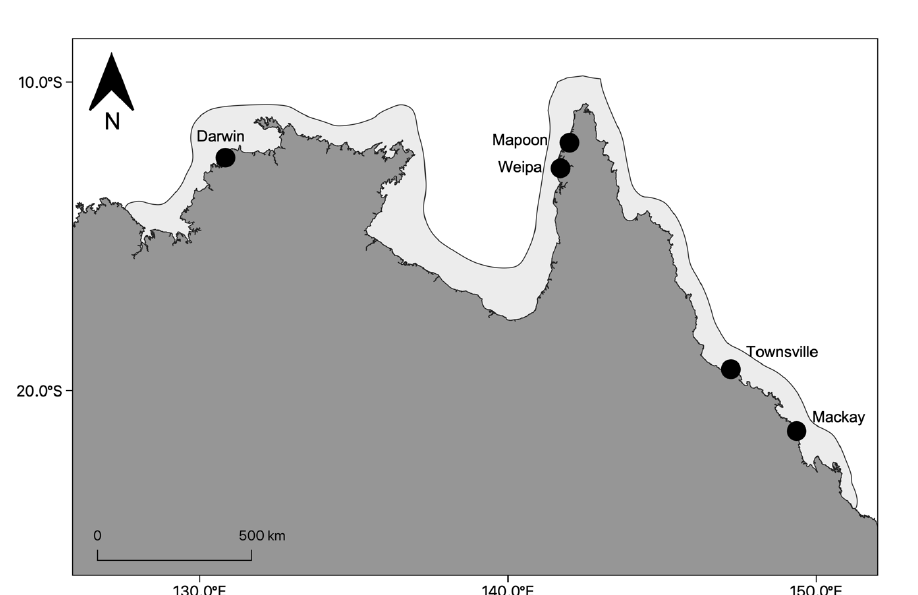
Figure 1. Map displaying the range of C. fleckeri in northern Australia (light grey) and collection locations of reference specimens (Darwin — n = 1, Weipa — n = 3, Townsville — n = 2 and Mackay — n =